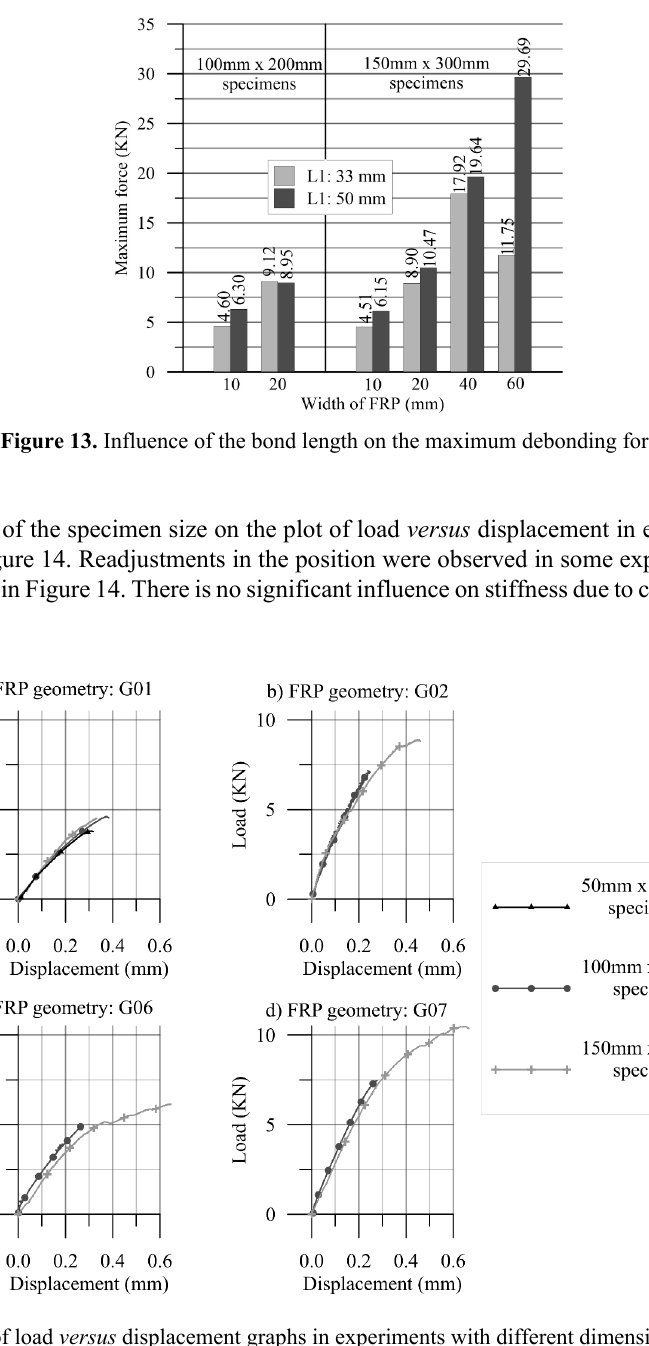
Figure 14. Initial portions of load versus displacement graphs in experiments with different dimensions of concrete specimens, the same FRP geometry, and debonding failure between concrete and